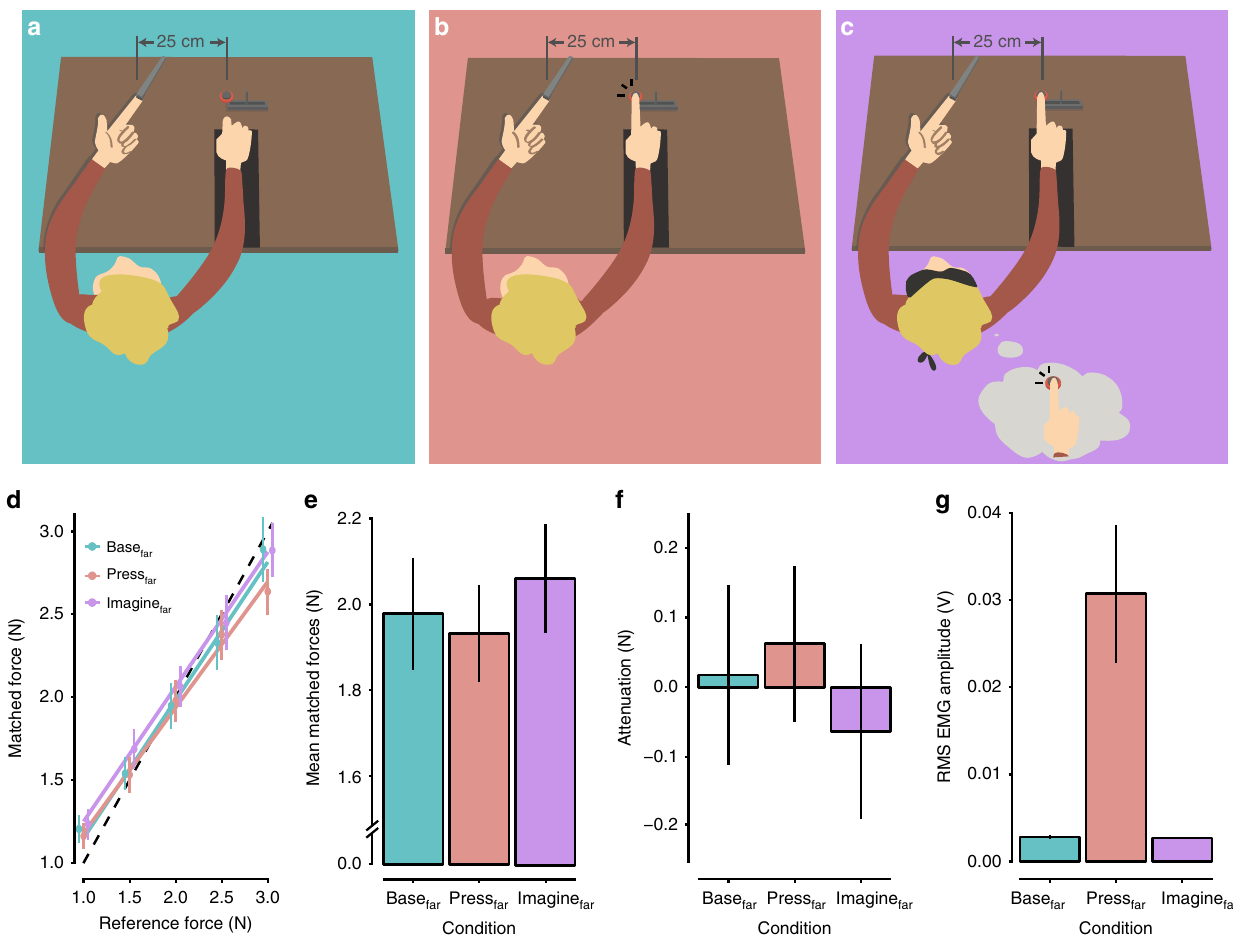
Fig. 2 Conditions of Experiment 2 and Results. a – c The conditions of Experiment 2 were identical to those of Experiment 1, with the only difference being that the participants ’ right hands, the sensor, and the slider were all placed 25 cm to the right of their left index fi ngers. As it has been shown that introducing such a distance between the hands eliminates somatosensory attenuation, we tested whether the same holds true for motor imagery. d Forces generated by participants (matched forces) as a function of the reference force (mean ± SE). There was no signi fi cant effect of condition on the participants ’ performances, i.e., we found no evidence for somatosensory attenuation (see main text for detailed results). e Mean matched forces displayed per condition (mean ± SE). There were no signi fi cant differences among the three conditions. f Somatosensory attenuation expressed as the difference between the reference forces and the matched forces per condition (mean ± SE). g Root-mean-square EMG activity of the right FDI muscle averaged across all applications of the reference force per condition (mean ± SE). Importantly, no signi fi cant difference was detected between the base far and imagine far conditions, showing that the participants were able to relax their hand in the motor imagery